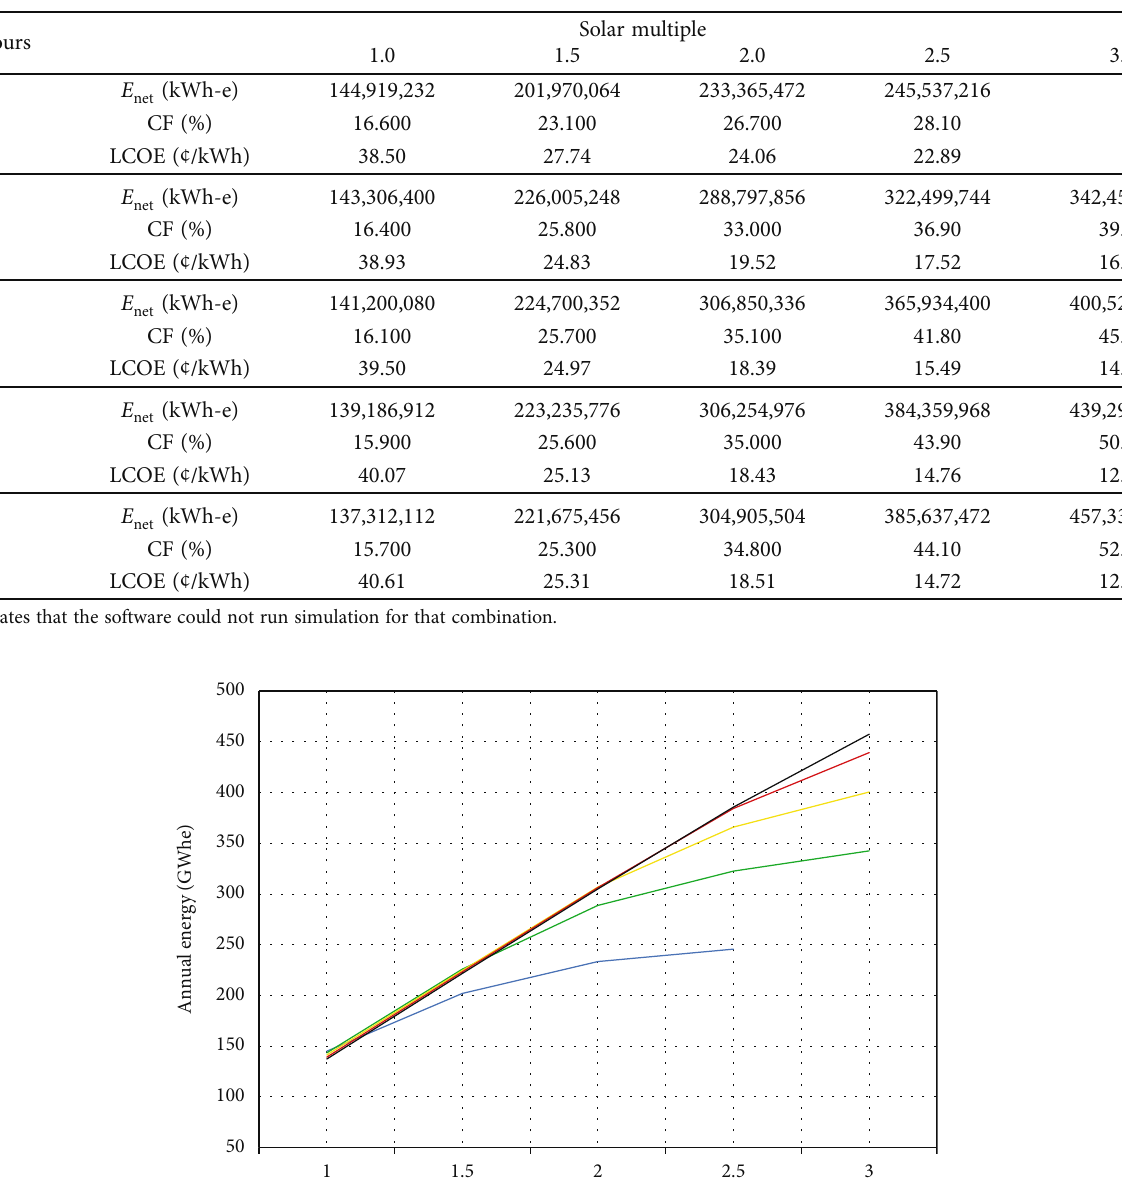
Table 8: Energy generation and capacity factor for varying SMs and TES hours.